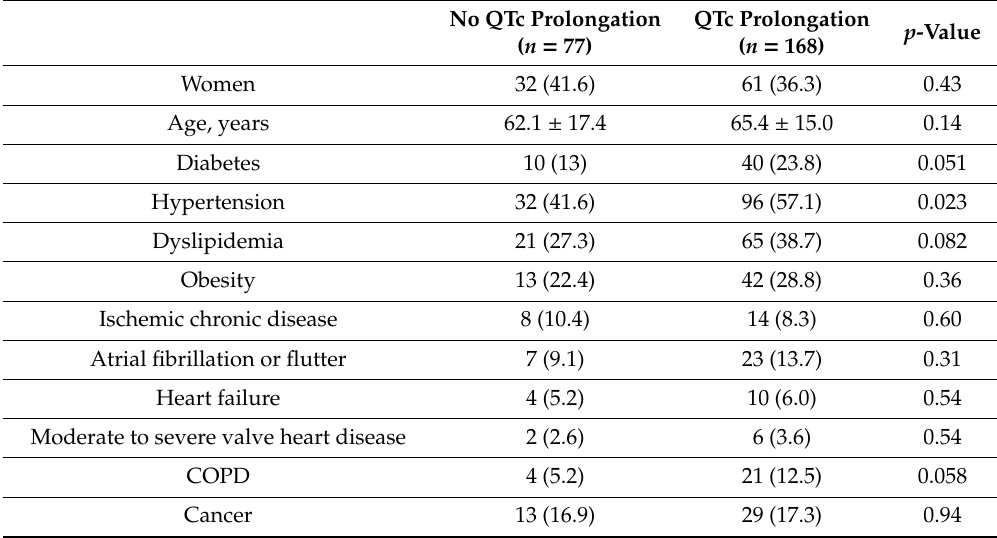
Table 3. Comparison of baseline characteristics, clinical presentation, treatment, and outcome between patients with and without QTc prolongation during